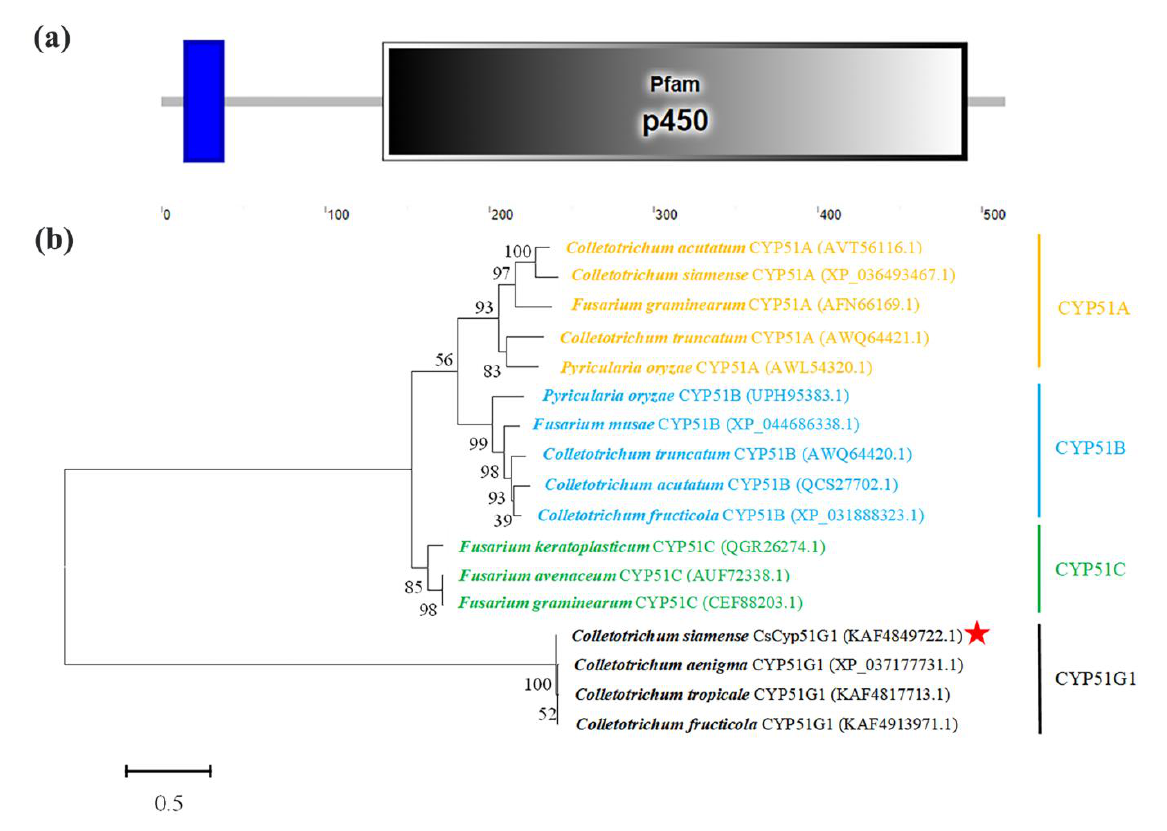
Figure 3. Protein domains and phylogenetic analysis of CsCyp51G1. ( a ) SMART analysis of the CsCyp51G1 protein domain. ( b ) Phylogenetic analysis of CsCyp51G1 and its homologues from other fungal species. The phylogenetic tree was constructed with MEGA 6.0 using the maximum likelihood method. The CsCyp51G1 protein amino acid sequence in this study is indicated with a red star.